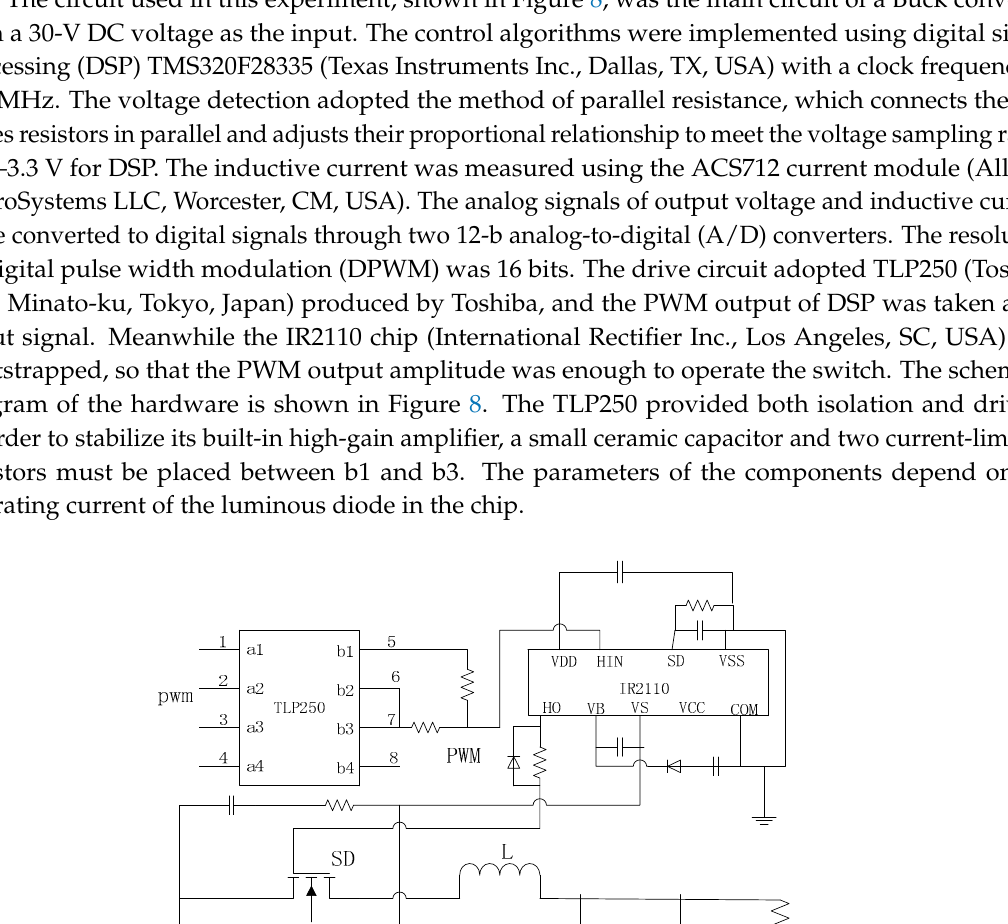
Figure 7. Simulated step ‐ input ‐ voltage waveform of the inductive current.